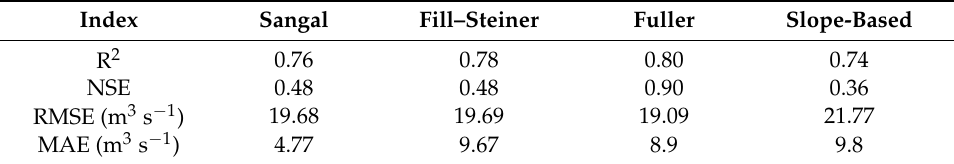
Table 3. Statistical comparison of Fuller, Sangal, Fill–Steiner, and Slope-based methods for the present period.